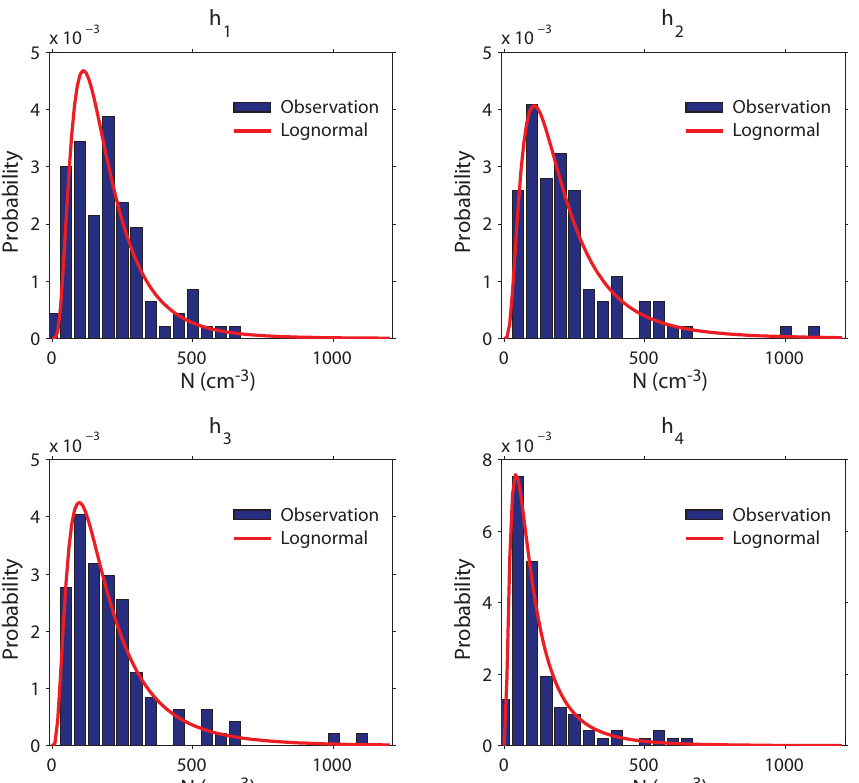
Fig. A2. Histogram of 10km-averaged PCASP aerosol concentrations N that are used in the susceptibility analysis. Each panel shows the distribution of N in the four cloud thickness bins. The red line shows the probability density function of a theoretical lognormal distribution, based on the arithmetic mean and standard deviation of N in each of the